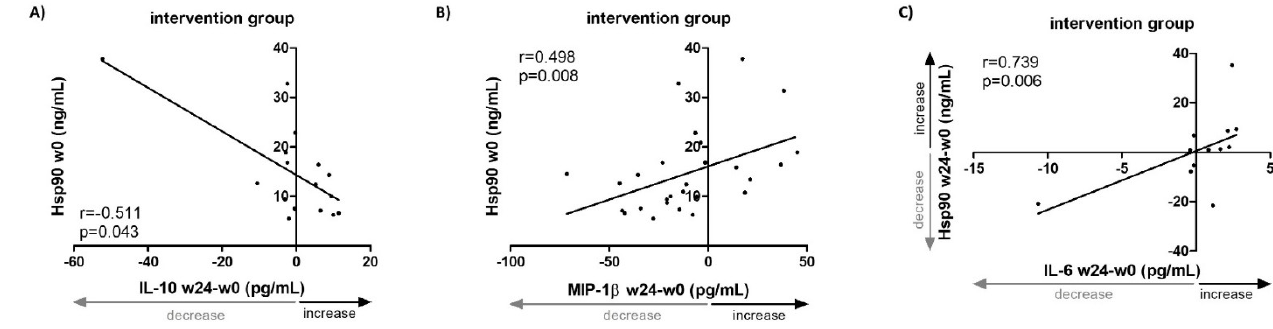
Figure 2. Associations of changes in systemic levels of Hsp90 and selected inflammatory cyto- kines/chemokines in patients with idiopathic inflammatory myopathies treated with standard-of- care pharmacotherapy (control group, CG, n = 23) or with additional non-pharmacological inter- vention (intervention group, IG, n = 27) for 24 weeks. Lower baseline plasma Hsp90 levels in IG predicted an increase in serum IL-10 ( A ) and a decrease in MIP-1 β ( B ) over weeks 0–24. ( C ) Changes in plasma Hsp90 levels in IG over weeks 0–24 correlated positively with changes in serum IL-6 over weeks 0–24. Changes in plasma Hsp90 levels in IG over weeks 0–12 correlated positively with changes in serum IL-2 ( D ) and negatively with MIP-1 β ( E ) over weeks 0–24. ( F ) Lower baseline plasma Hsp90 levels in CG predicted a decrease in serum IL-10 over weeks 0–24. Changes in plasma Hsp90 levels in CG over weeks 0–24 correlated positively with changes in serum IL-8 ( G ) and TNF ( H ) over weeks 0–24. ( I ) Changes in plasma Hsp90 levels in CG over weeks 0–12 correlated posi- tively with changes in serum IL-7 over weeks 0–24. W, week. 2.2. Hsp90 Levels in IIM Patients: The Control Group (n = 23) In the CG of IIM patients who were only on continued standard-of-care immunosup- presive pharmacotherapy but did not undergo physiotherapy, higher baseline (week 0) plasma Hsp90 levels predicted a decrease in plasma Hsp90 over weeks 0–12 (r = − 0.676, p < 0.001) (Figure 1F) and 0–24 (r = − 0.842, p < 0.001) (Figure 1G). Furthermore, a decrease in plasma Hsp90 in the first 12 weeks of the intervention was associated with a decrease over the entire 24 weeks (r = 0.942, p < 0.001) (Figure 1H, Table S3). Regarding inflammatory markers, in the CG we observed a significant increase in IL- 2 and IL-6 and a significant decrease in IL-9, MIP-1 β , MCP-1, RANTES, and TNF (Table